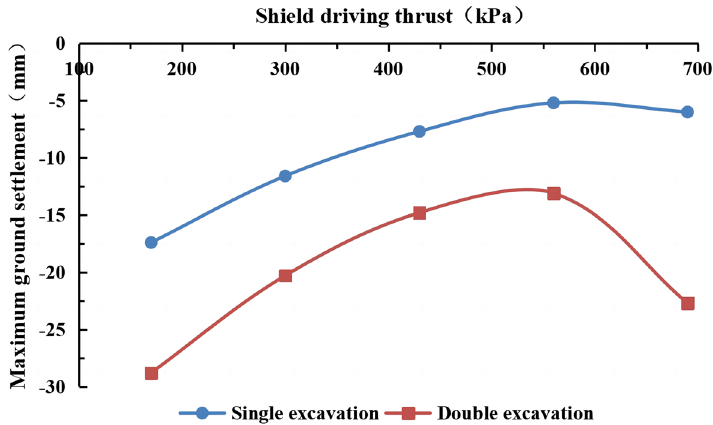
Figure 28. The maximum surface subsidence for different thrust forces of the shield machine.